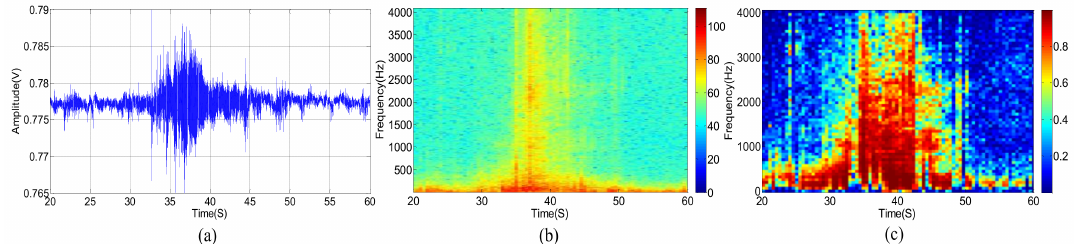
Figure 5. ( a ) Acoustic signal of a vehicle in the presence of wind noise. ( b ) Power Spectrum of a vehicle in the presence of wind noise. ( c ) Sub-band magnitude squared coherence (SMSC) of the vehicle’s spectrum signal in the presence of wind